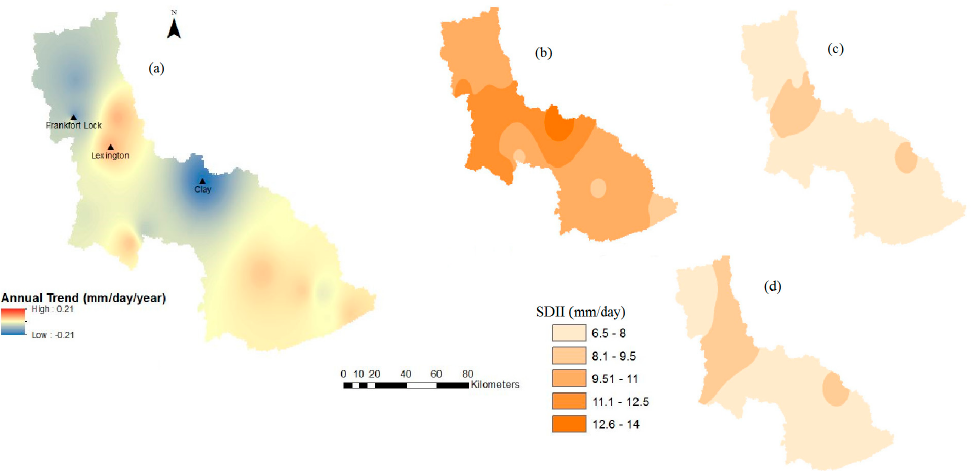
Figure 10. Spatial distribution of SDII ( a ) trend and mean values under: ( b ) baseline; ( c ) late ‐ century RCP 4.5; and ( d ) late ‐ century RCP 8.5, in the Kentucky River Basin. Filled triangles indicate a statistically significant ( p < 0.05) trend.